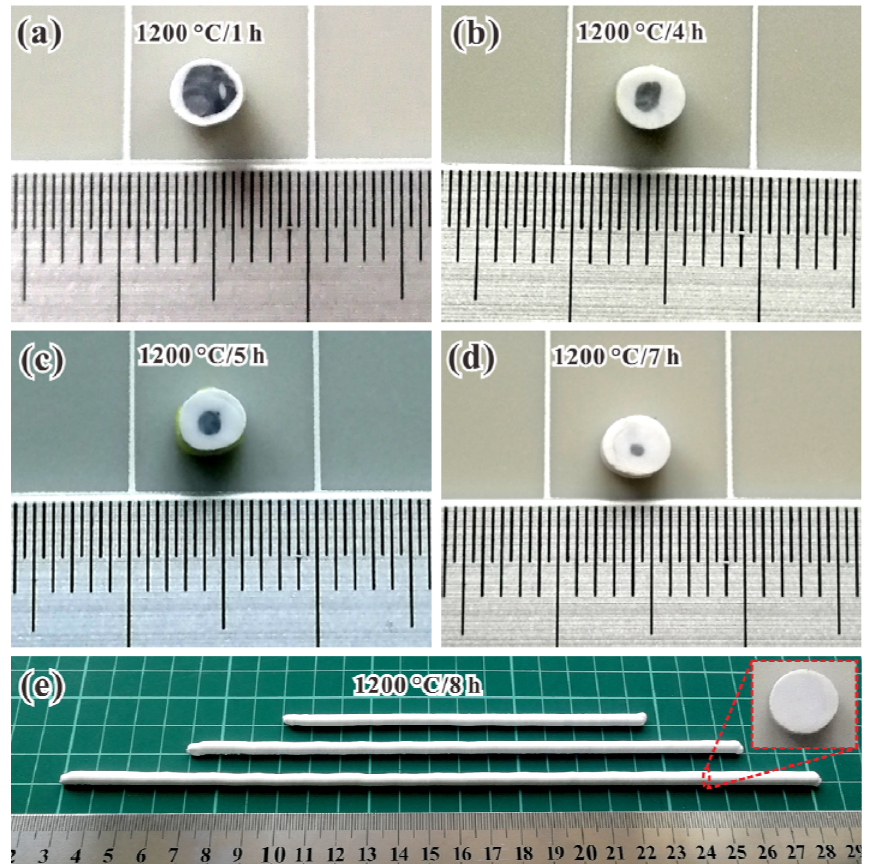
Fig. 2 3D-printed Al 2 O 3 /GdAlO 3 /ZrO 2 eutectic samples after annealed at 1200 for different hours: (a) 1 h, (b) 4 h, (c) 5 h, ℃ (d) 7 h, and (e) 8 h.